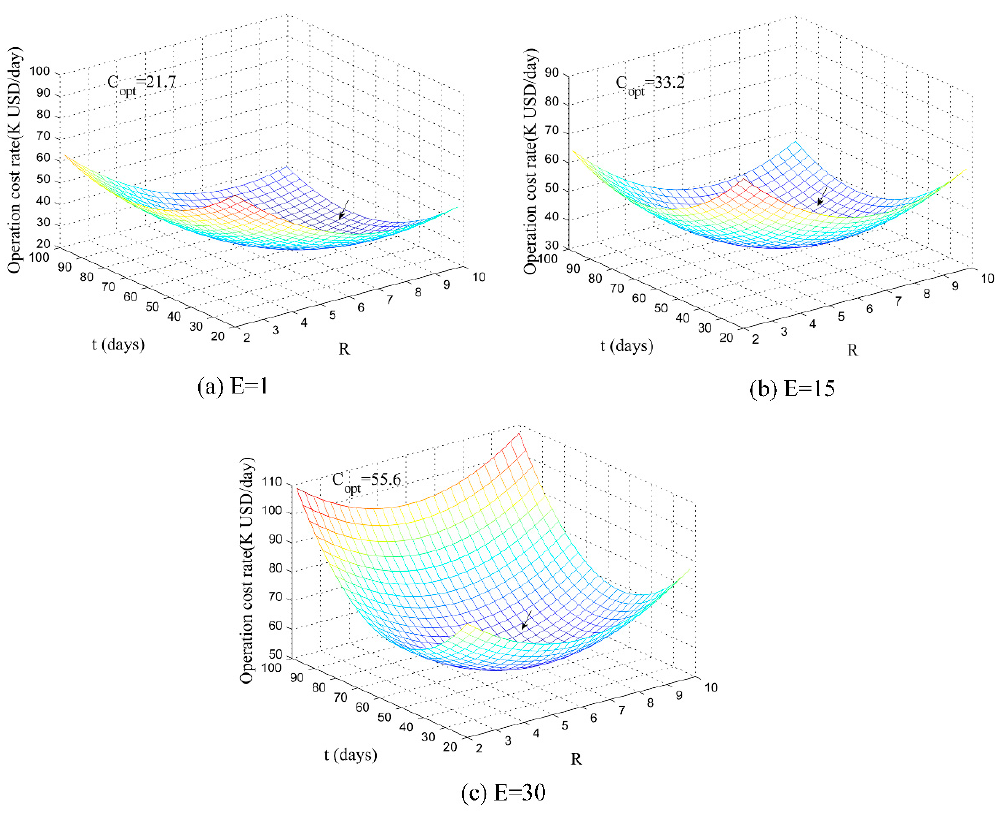
Figure 5. LACR obtained with different soft cost rate: ( a ) E = 1; ( b ) E = 15; ( c ) E = 30.